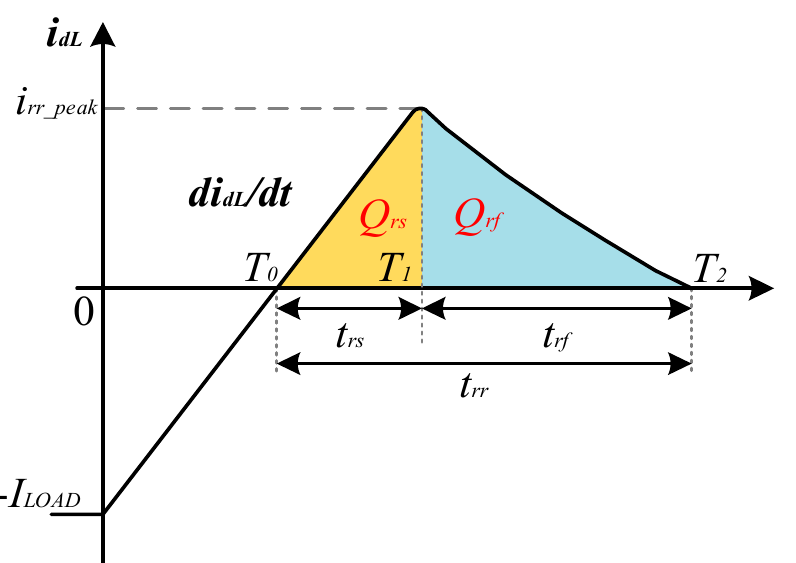
Figure 10. Modeling of the reverse recovery process of the antiparallel freewheeling diode.